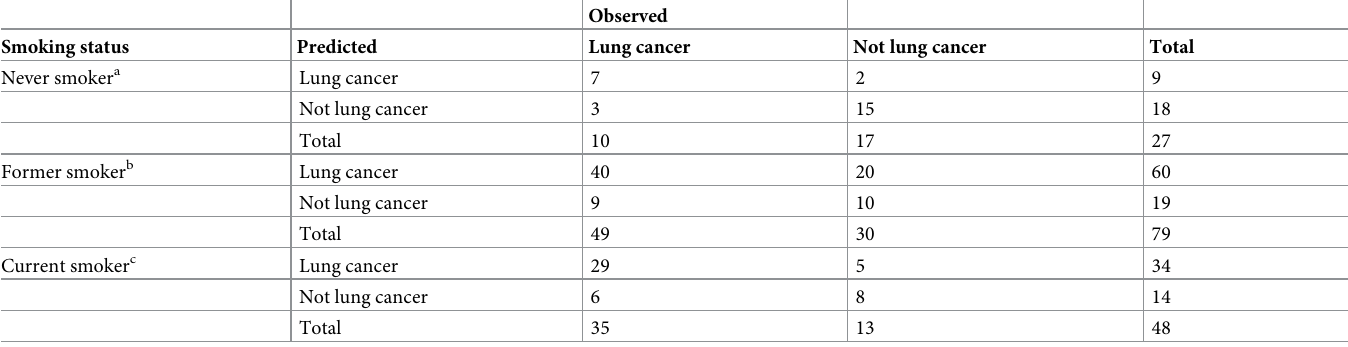
Table 2. Confusion matrixes for predictions of lung cancer status for patients in the test data sets using stochastic gradient boosting models from the training data sets, according to smoking status.